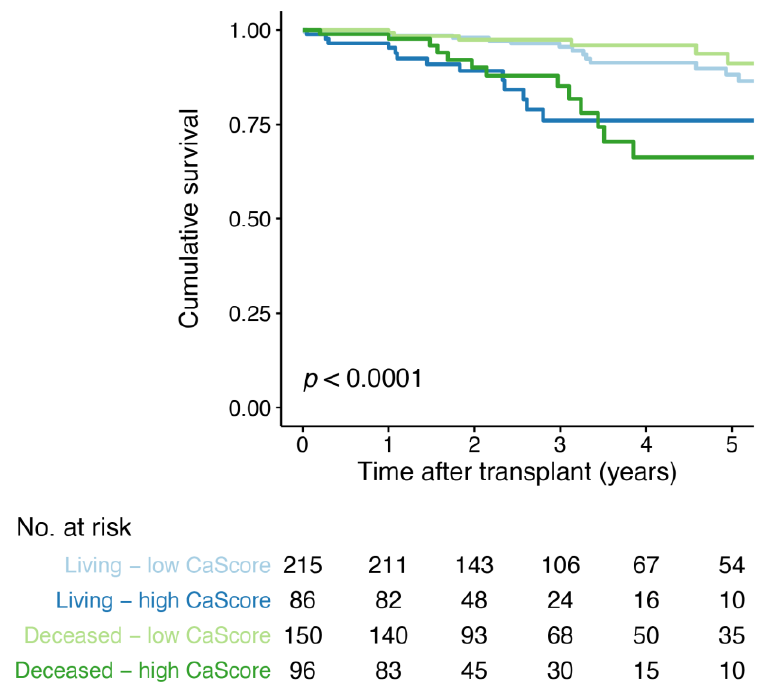
Figure 3. Kaplan–Meier survival curve for death with a functioning graft free-survival for the low and high aorto-iliac CaScore group, stratified by living and deceased donor kidney transplantation. Number at risk (No. at risk) provided for all four groups.